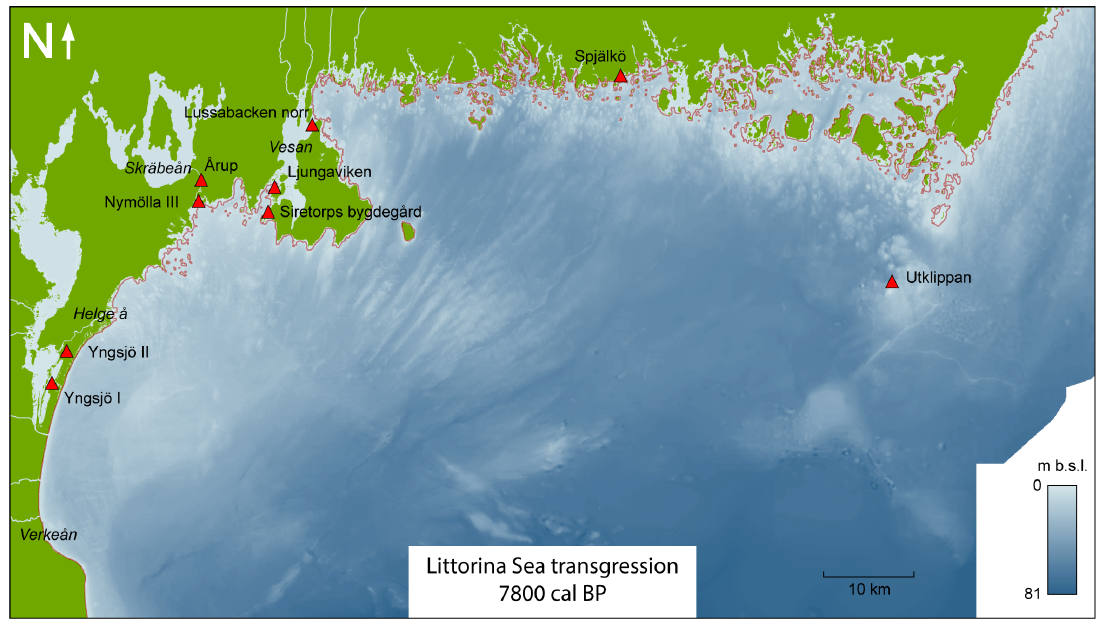
Figure 10. Palaeo-shoreline reconstruction of the study area during the Littorina Sea transgression. The red line represents the present coastline. Red triangles represent the archaeological site discussed in the text. Light blue lines represent rivers discussed in the